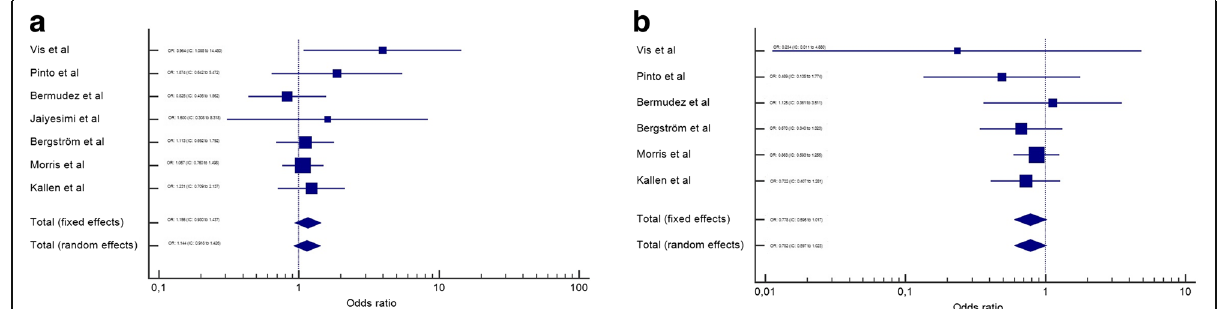
Fig. 4 Meta-analysis of PDA and TOF by gender in Down syndrome. IC-Interval of confidence. OR-Odds Ratio. a – OR meta-analysis of PDA in Down syndrome by gender. b – OR meta-analysis of TOF in Down syndrome by